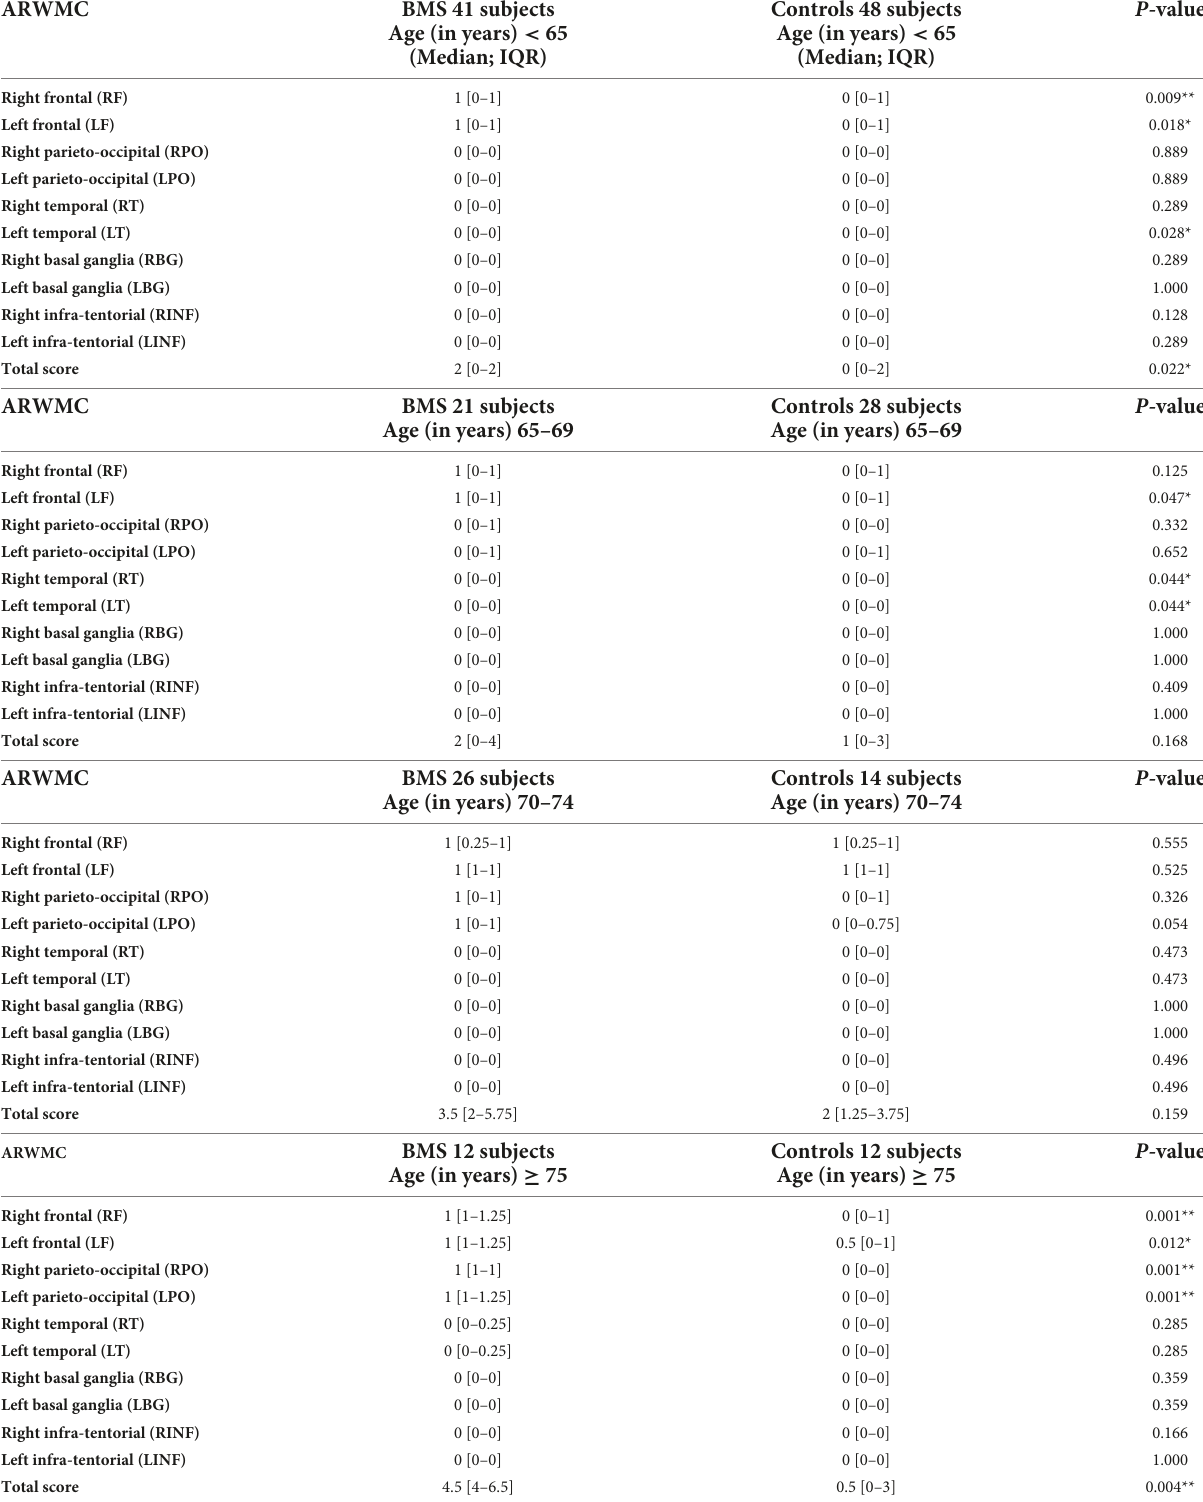
TABLE 4 Analysis of the ARWMC scores of the patients with BMS and the healthy controls according to the age